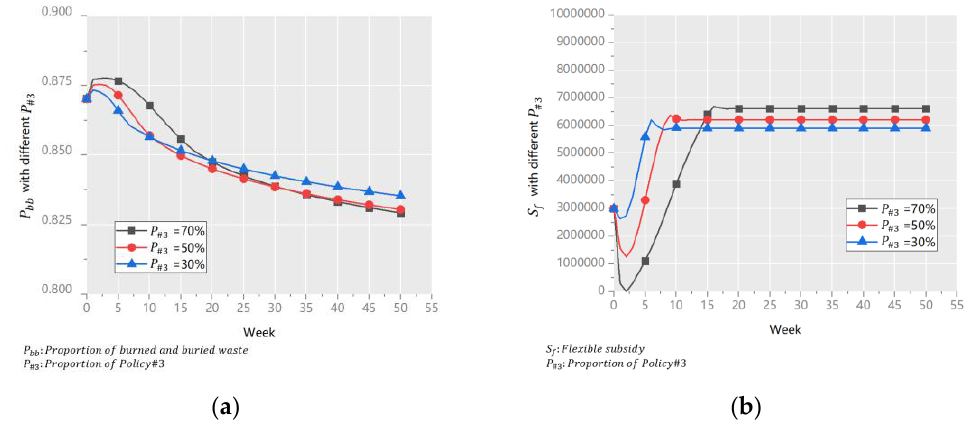
Figure 9. P bb ( a ) and S f ( b ) with different P #3. Figure 9. P